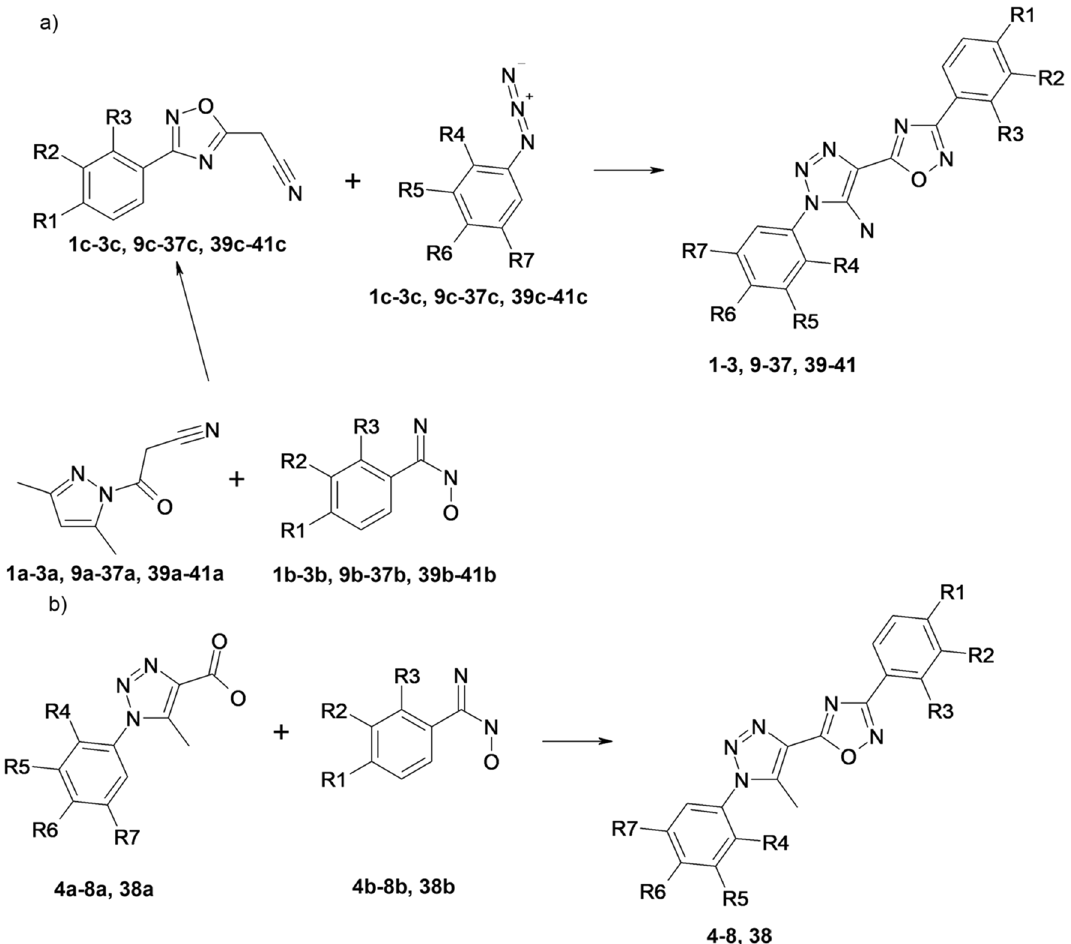
Figure 3. The synthesis pathway for 3-phenyl-5-(1-phenyl-1H-[1,2,3]triazol-4-yl)-[1,2,4]oxadiazole derivatives with R 8 = NH 2 (compounds 1–3 , 9–37 , 39–41 ) ( a ) and general synthetic procedure for 3-phenyl-5-(1- phenyl-1H-[1,2,3]triazol-4-yl)-[1,2,4]oxadiazole derivatives with R 8 = CH 3 (compounds 4–8 , 38 ) ( b